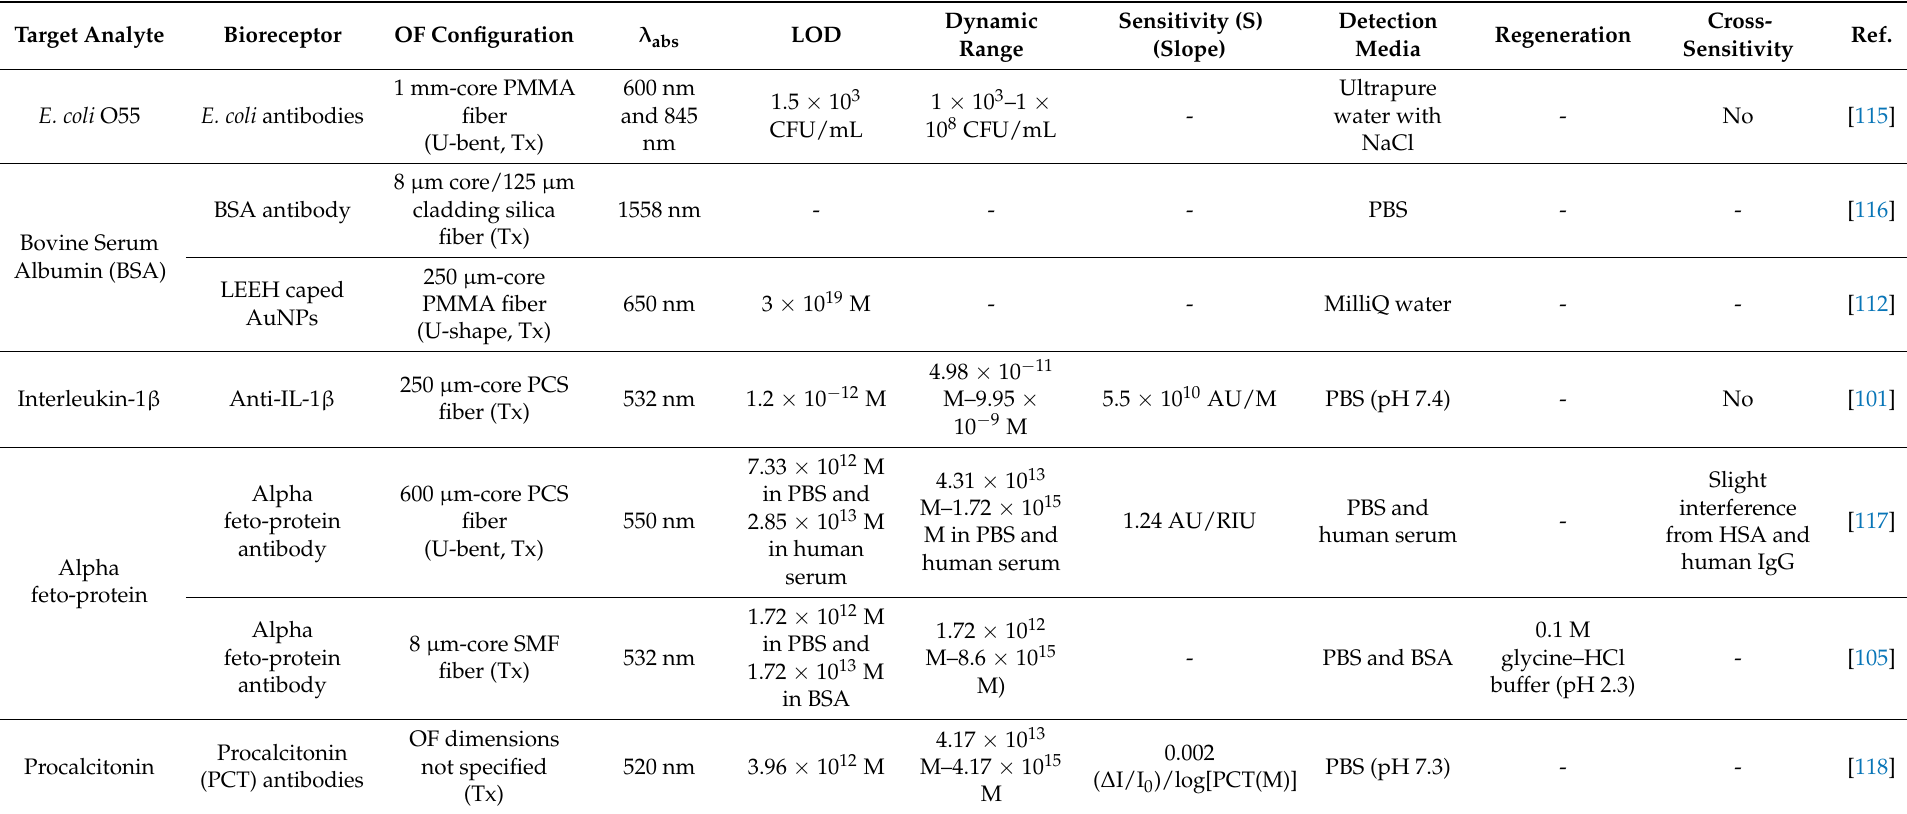
Table 6. Optical fiber biosensors based on absorption using other antibodies than IgG or HIgG as bioreceptors. The dash indicates that information about that parameter is not available in the original